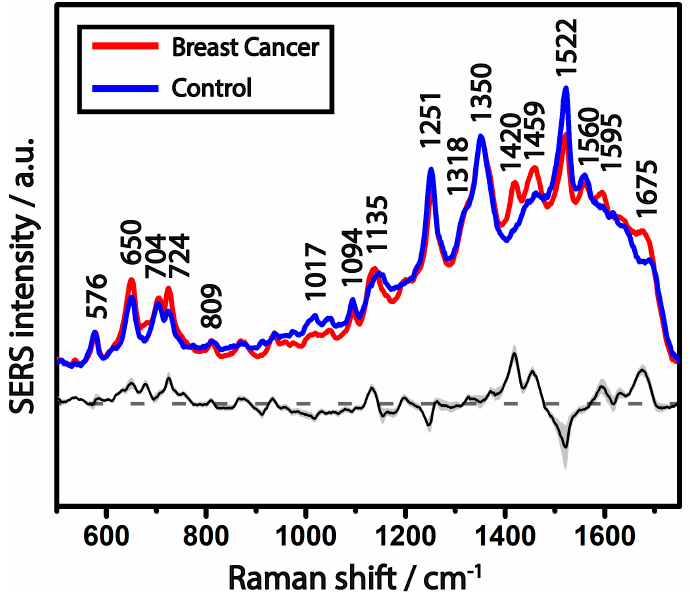
Figure 3. Average surface-enhanced Raman scattering (SERS) spectra of urine samples from breast cancer patient (n = 53) and controls (n = 22) and the difference spectrum. Shaded area represents standard deviation.